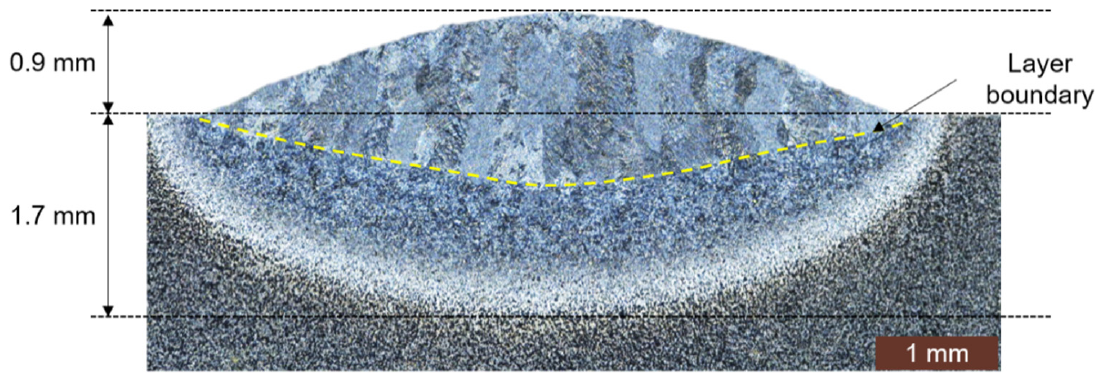
Figure 7. The range of the heat-affected zone under the given process parameters.